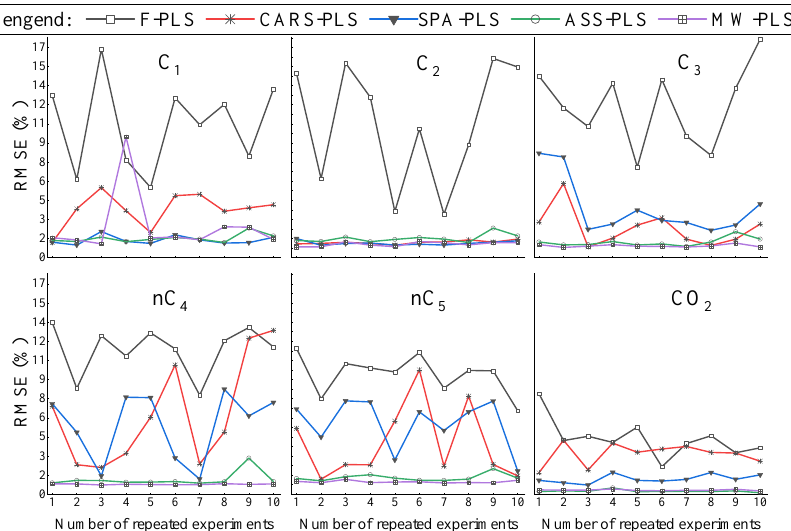
Figure 13. The performance of five different quantitative analysis methods for 10 repeated tests in the six-component dataset. The horizontal axis represents the number of repeated tests, and the vertical axis represents the model accuracy by RMSE